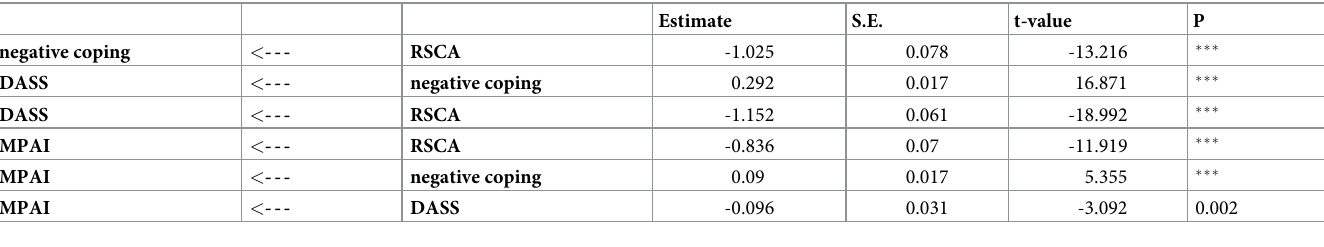
Table 4. Results of the structural model: Tests of hypothesized associations between